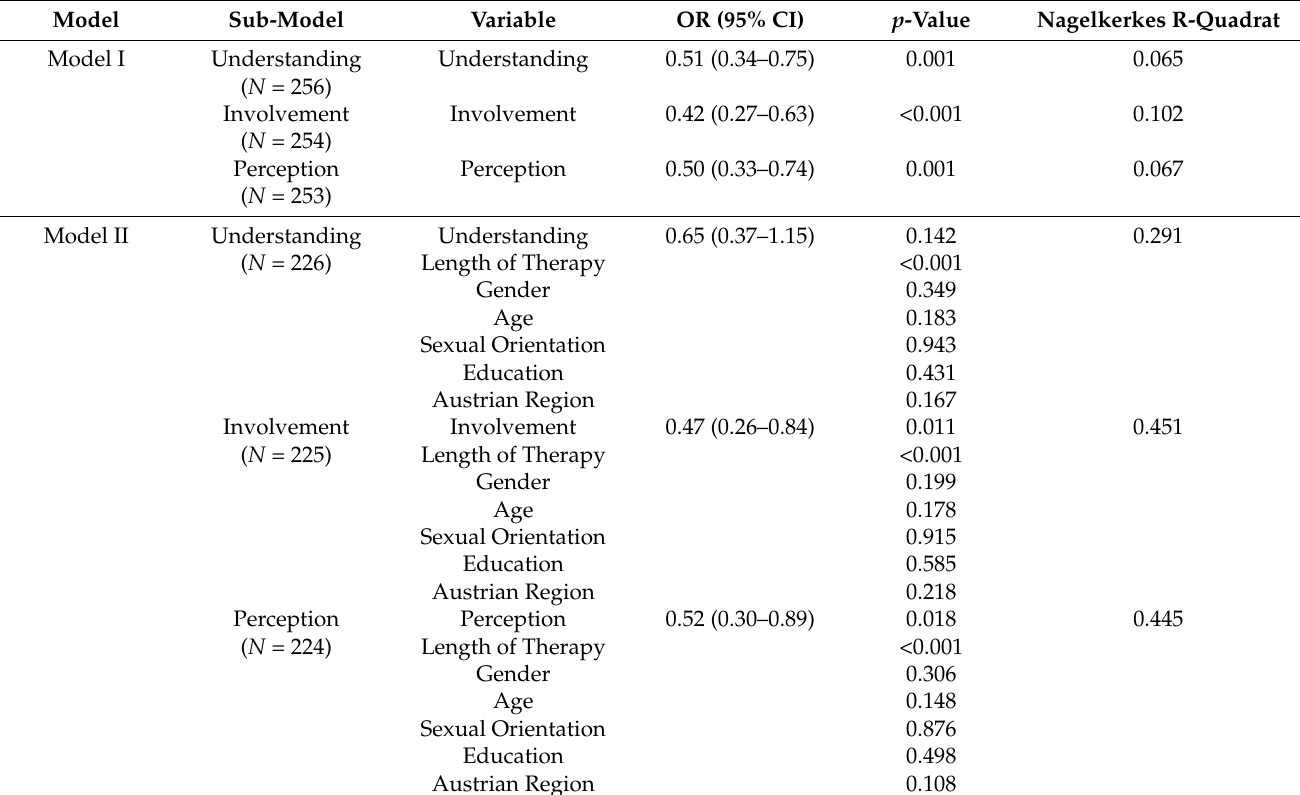
Table 2. Logistic regression for non-adherence on relationship aspects, including model adjustments for therapy duration and sociodemographic characteristics.